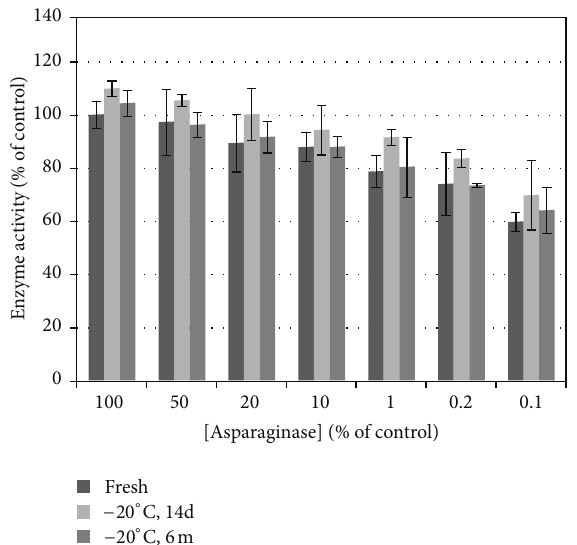
Figure 8: Effect of freeze/thaw on asparaginase enzyme activity. The number of freeze/thaw cycles accounts for a minor portion of the statistical variance between cold storage groups. Post hoc tests did not identify a significant difference between any cold storage type compared to control. This verifies that frozen stocks retained enzyme activity with freeze-thaw cycles similar to freshly prepared